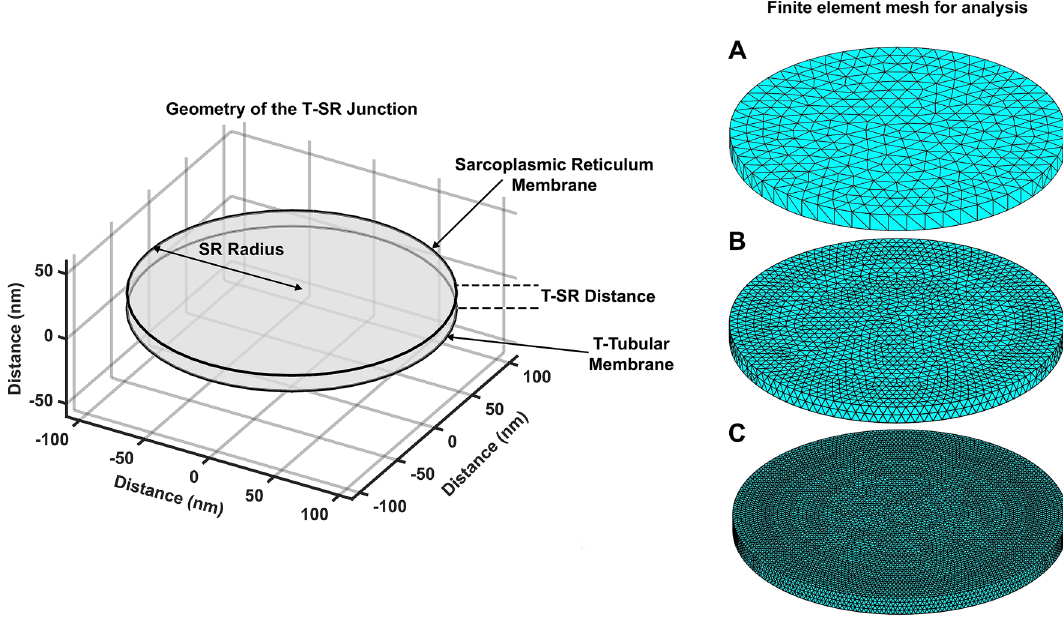
Figure 1. T-SR junction structure represented using a formal geometric model divided into finite elements. Left: Geometrical representation of formalized T-SR junction represented as two disks, respectively of tubular (T) and sarcoplasmic reticular (SR) membranes, of diameter, d = 220 nm, within the radial ( xy ) plane, separated along an axial ( z ) direction by a T-SR distance, w = 12 nm. Right: Superimposition of finite elements